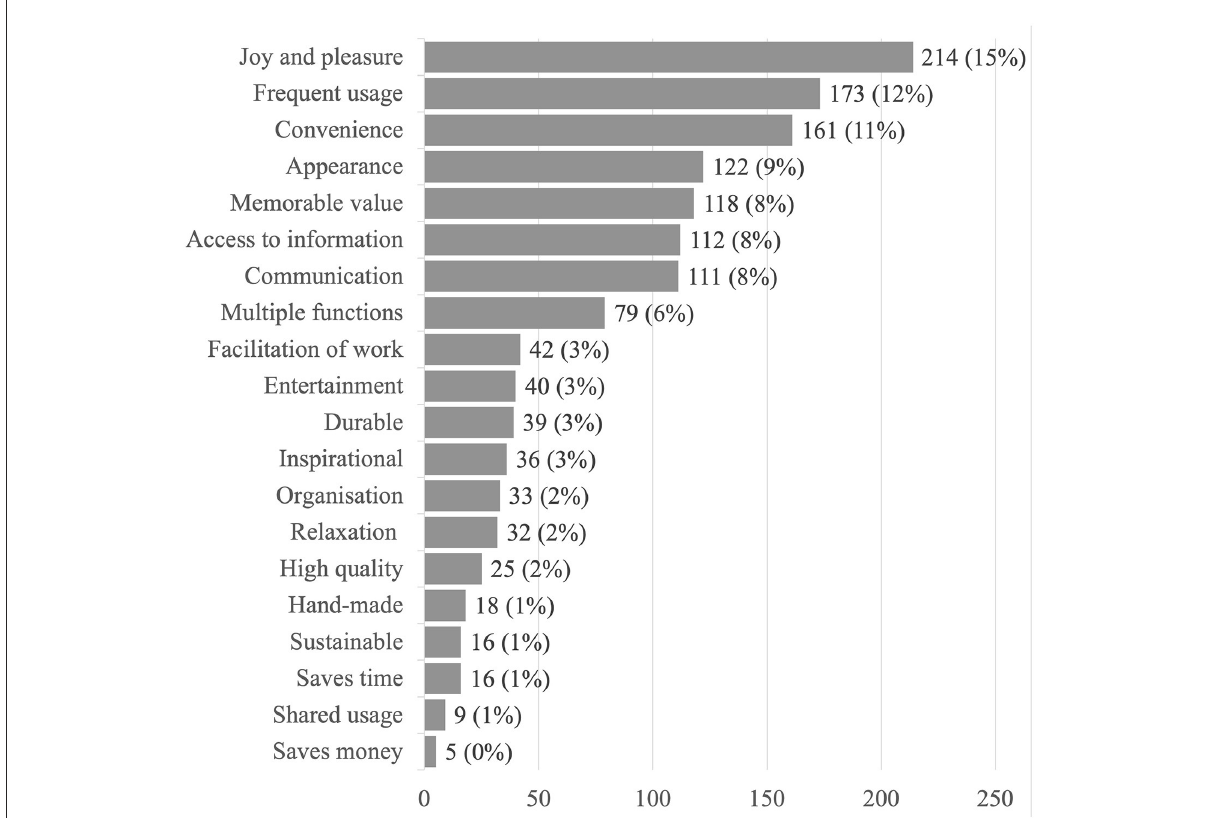
FIGURE3 What makes the good important to you? (percentage refers to mentions of terms in each category in relation to the total number of